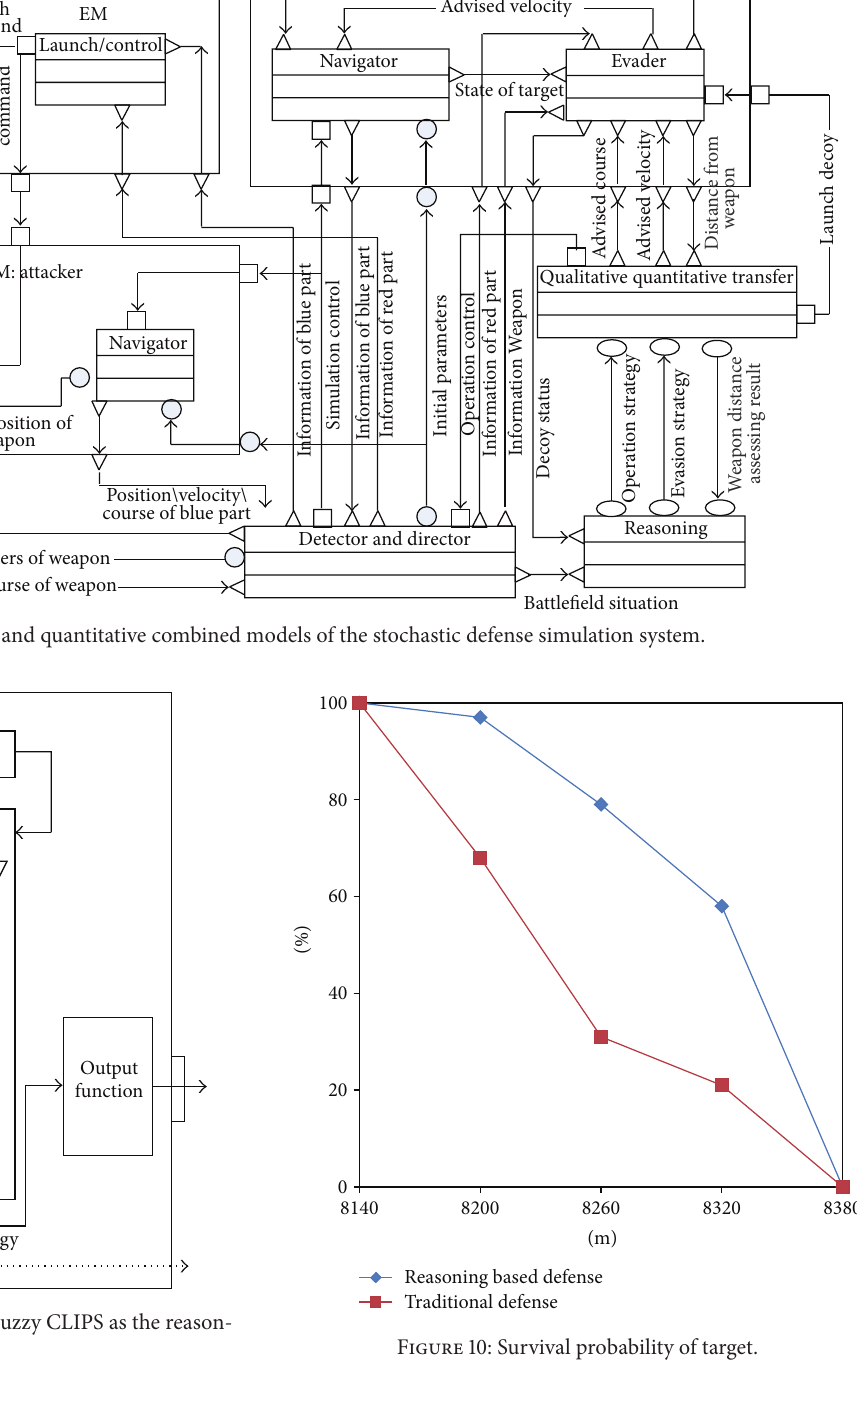
= > 𝐸𝑀 ⊓ interface ≡ 𝐶𝑀 ⊓ interface.